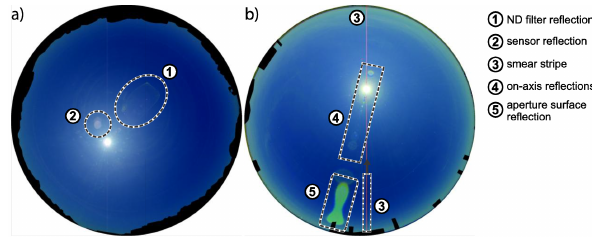
Figure 12. Stray light comparison between two designs of the USI; (a) design with filter, and (b) design with modified